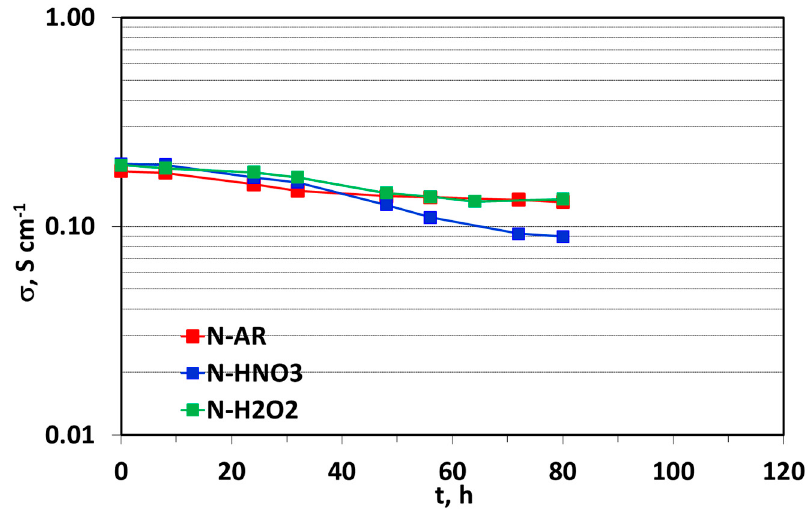
Figure 7. Proton Conductivity at 80 °C and 100% RH as a function of time.